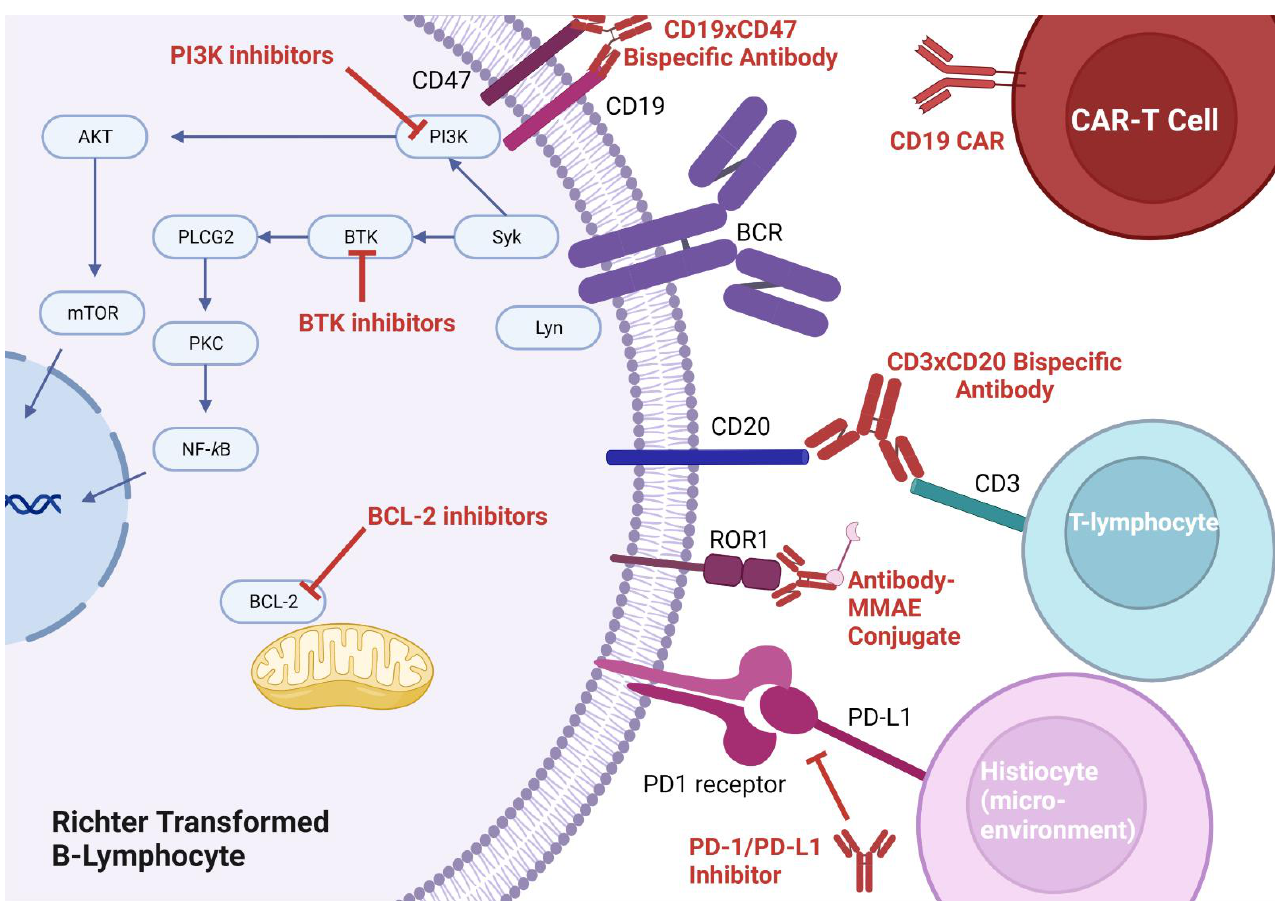
Figure 1. Mechanisms of action for novel targeted therapies in Richter Transformation. BTK inhibitors disrupt signaling from the surface B-cell receptor (BCR) to the canonical nuclear factor κB (NF-κB) pathway. PI3k inhibitors primarily disrupt signaling from surface CD19 to the mammalian target of rapamycin (mTOR) pathway although there is debate that PI3K may interact with other pathways. BCL-2 inhibitors disrupt mitochondrial associated anti-apoptotic pathways and induce cell death. Antibodies directed at program cell death-1 receptor or its ligand (PD-1 and PD-L1 respectively) seem to interfere with tumor microenvironment stimulation of neoplastic cell growth. Bi-specific T-cell engagers (BiTEs) are a class of bispecific antibodies which bring T-cells in proximity of cancer cells (the example shown here is an anti-CD3xCD20 bispecific). Anti-CD19xCD47 antibodies represent another class of bispecific antibodies which target two antigens on a neoplastic cell, making these antibodies more selective for neoplastic cells than traditional monoclonal antibodies. CAR-T cells are engineered T-cells with chimeric receptors designed to target cancer cells (the example shown here is an anti-CD19 CAR T-cell). Antibody-MMAE conjugates allow for the delivery of the potent anti-tubulin drug MMAE, which halts cytoskeletal elements and inhibits cell division. The first published study investigating the role of BTKis in RT-DLBCL was a case series of 4 patients, the majority of whom had relapsed/refractory RT. Only 3 out of 4 patients were evaluable. All 3 evaluable patients responded (1 CR and 2 PRs), with a median duration of response (DOR) of 6.1 months. Only one patient received ibrutinib monotherapy in the frontline (This patient had a 17p chromosomal deletion and heavily pretreated CLL.) and achieved a PR with a sustained response of 10.8 months (the longest DOR of the 3 patients)